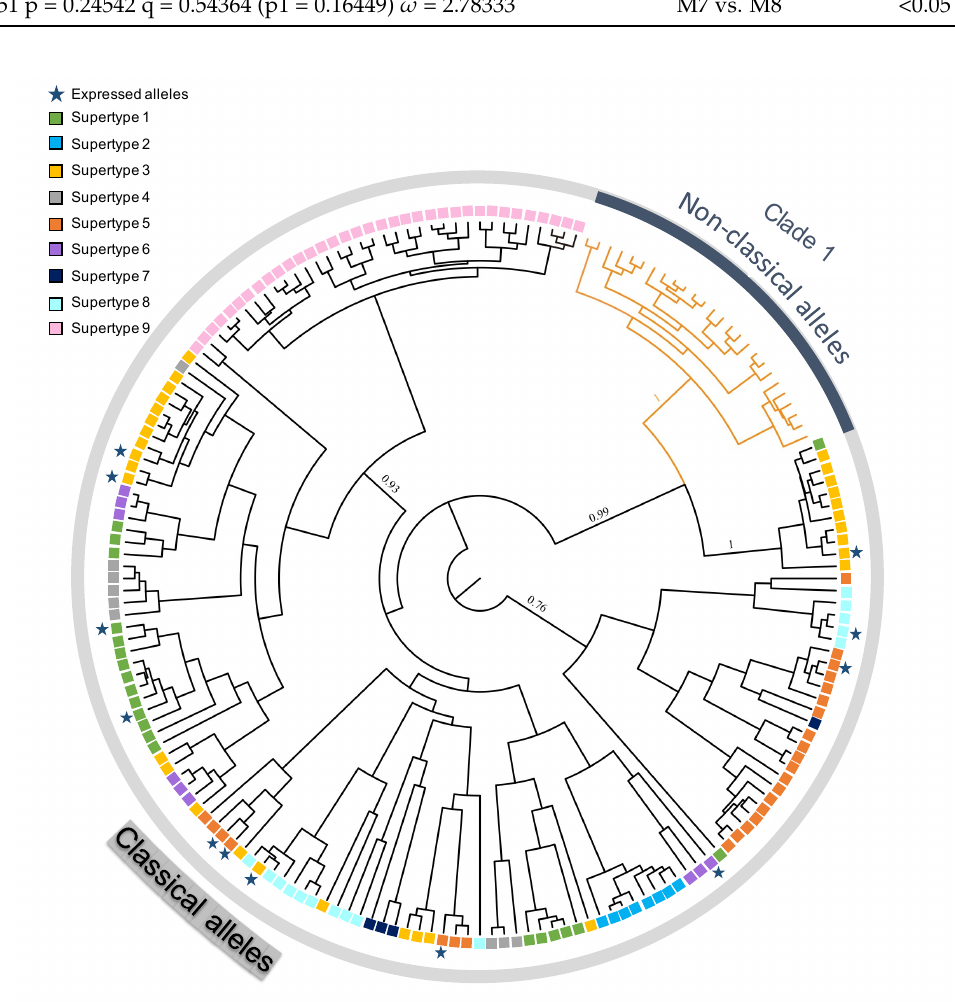
Figure 1. Bayesian phylogenetic tree depicting the major subset of MHC alleles in Godlewski’s bunting. Asterisks indicate the expressed alleles. Posterior probabilities higher than 0.70 are shown by the node. The clade 1 in orange with high support without any expressed alleles was identified as non-classical